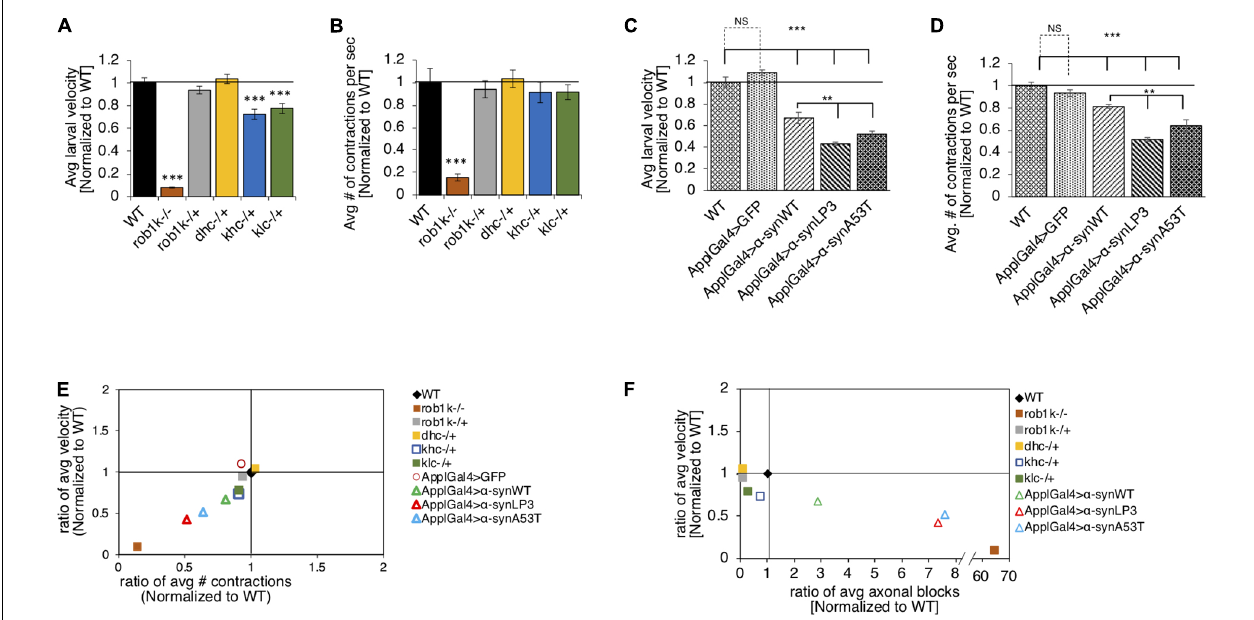
FIGURE 3 | Excess human α -syn causes larval locomotion defects, similar to what was observed in molecular motor protein mutant larvae. (A) Quantification analysis of the average larval crawling velocity (normalized to WT) from larvae with a complete loss of dynein (robI − / + ), or a 50% reduction of kinesin (khc − / + or klc − / + ) or dynein (robI k − / + or dhc − / + ) normalized to WT control. The larval crawling velocity of larvae carrying a homozygous dynein (robl k − / − , p < 0.001) mutation was significantly reduced compared to WT, while heterozygous dynein larvae (robl k − / − or dhc − / + ) were similar to WT. Larvae with 50% reduction of kinesin-1 (khc − / + or klc − / + ) show a significant decrease in larval crawling velocity compared to WT ( p < 0.001). (B) The average number of peristaltic contractions during 60 s (normalized to WT) for motor protein mutants. Note that only homozygous dynein robl k − / − ( p < 0.001) larvae show significant decreases in contractions. (C) Quantification of the average crawling velocity (normalized to WT) for larvae expressing α -syn WT , α -syn LP3 , or α -syn A53T are significantly reduced compared to WT or GFP alone ( p < 0.001). The average velocity of larvae expressing α -syn LP3 or α -syn A53T was significantly reduce compared to α -syn WT larvae ( p < 0.01). (D) Quantitative analysis of the average number (#) of contractions in 60 s (normalized to WT) for larvae expressing α -syn WT , α -syn LP3 , or α -syn A53T indicates significant decreases in contractions compared to WT or GFP alone ( p < 0.001). A significant reduction was also observed in the average larval contractions of larvae expressing α -syn LP3 or α -syn A53T compared to α -syn WT ( p < 0.01). (E) The ratio of the average contractions ( X -axis) plotted against the ratio of the average velocities ( Y -axis) (WT normalized to 1) for motor mutants and α -syn expressing larvae. Note that as contractions decease so does the larval velocity. (F) The ratio of the average number of axonal blocks ( X -axis) plotted against the ratio of the average larval velocity ( Y -axis) for motor protein mutants and α -syn-expressing larvae. Note that as the number of axonal blocks increases, the larval velocities decrease. Quantitative analysis represents the mean ± SEM. ∗∗ p < 0.01, ∗∗∗ p < 0.001, n =